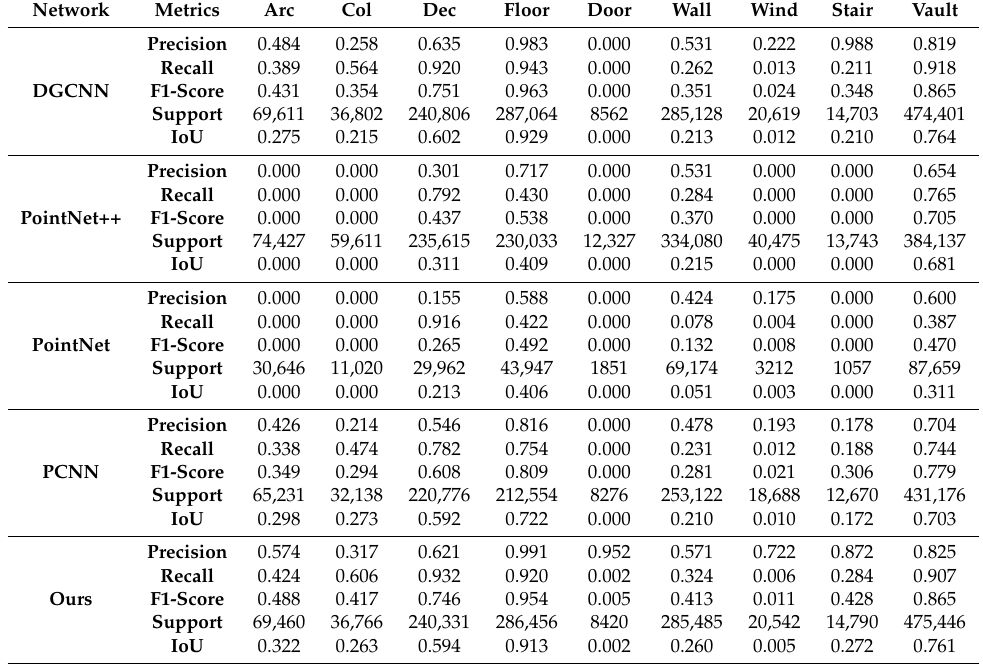
Table 4. The scene was divided into 3 parts: Train, Validation, Test. In this table we can see the metrics for every class, calculated on the Test